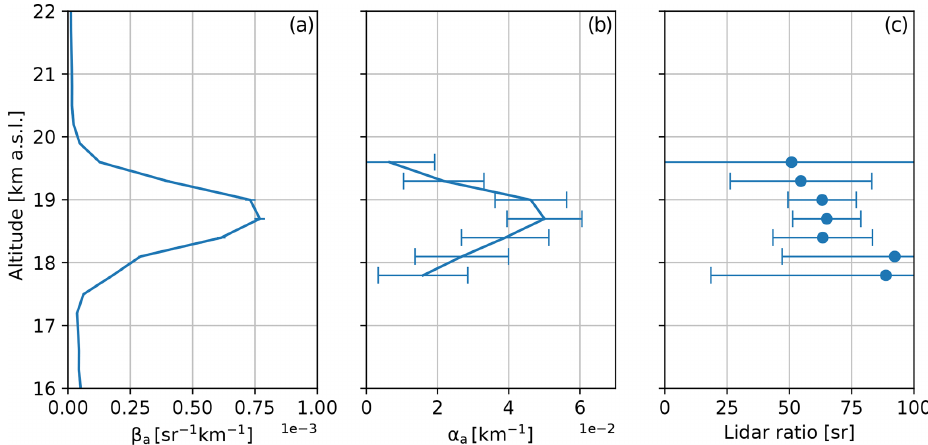
Figure 10. Backscatter (a) and extinction coefficient (b) profiles at 355nm measured by MLSOL on 19 July 2011. The derived lidar ratio is also shown (c)